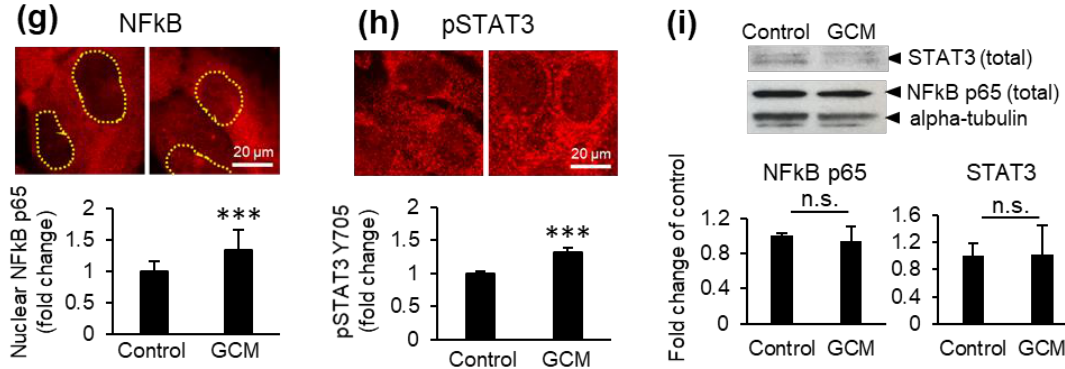
Figure 3. Glioblastoma (GBM) invasiveness in 3D co-cultures. ( a ) Collagen gels were seeded with human primary astrocytes and human HMC3 microglia in the presence or absence of a glioblastoma tumoroid. ( b ) Glioblastoma invasiveness in the presence or absence of microglia and astrocytes in 3D co-cultures after 6 days. Shown are the average distance of outgrowth from the tumoroid as a fold change of the tumoroid monoculture ± SEM. A total of 32 tumoroids were tested from at least three independent experiments. * p < 0.05 ( c ) Schematic representation of microglial conditioned media (MCM) used to treat collagen-embedded tumoroids. ( d ) Glioblastoma tumoroid outgrowth in the presence of conditioned media from microglia treated or not with dPGS (1 µ M) after 6 days ± SEM. A total of 29 tumoroids were tested from at least four independent experiments. * p < 0.05 ( e ) Representative fluorescence micrographs showing intracellular LCN2 (red) in glioblastoma cells in the presence or absence of microglia cells in direct co-culture and dPGS (1 µ M) for 24 h. LCN2 was fluorescently immunolabeled and cells were imaged using a fluorescence microscope. Quantifications show the average intracellular LCN2 levels ± SD per cell. At least 500 cells were analyzed from five independent experiments. *** p < 0.001; n.s. Non-significant. ( f ) Fluorescence micrographs of LCN2 (red) and GFAP (white) in human brain sections from non-cancerous brain or glioblastoma tumor tissues. LCN2 and GFAP were fluorescently labeled by immunohistochemistry and imaged using a fluorescence microscope. ( g,h ) Activation of transcription factors NF κ B and STAT3 in microglia in response to glioblastoma secreted factors. Human HMC3 microglia were treated with glioblastoma conditioned media (GCM) for 24 h, after which NF κ B p65 and phosphorylated STAT3 Tyr705 were fluorescently immunolabeled (red) and cells were imaged using a fluorescence microscope. Shown are (g) the average nuclear NF κ B p65 level per cell ± SEM (237 cells from three independent experiments) and (h) the average pSTAT3 Y705 level per cell ± SEM (317 cells from three independent experiments) *** p < 0.001. ( i ) Total NF κ B p65 and STAT3 protein abundance in microglia treated as in (g,h). Protein levels were determined by measurements of immunopositive bands in Western blots. Alpha-tubulin was used as loading control. Shown are the average protein abundance of NF κ B p65 and STAT3 from three independent experiments. n.s.